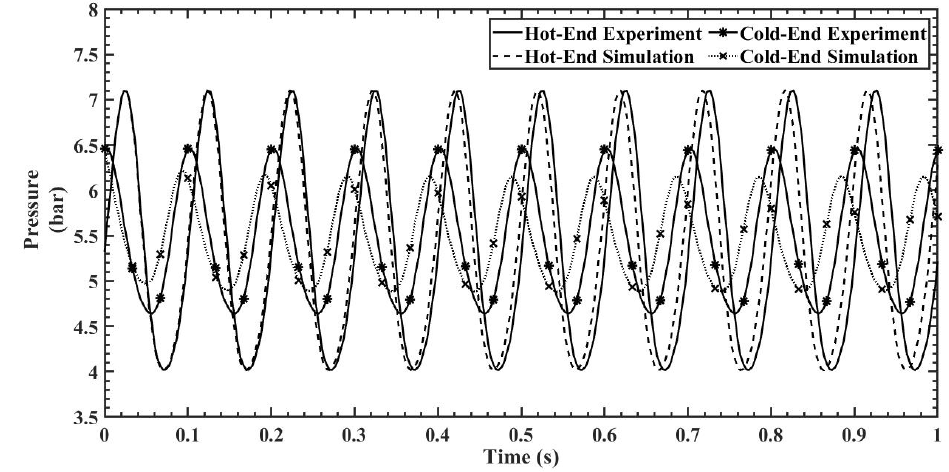
Figure 18. Hot- and cold-section pressure characteristics of a 200 mesh regenerator at 600 RPM. For a 200 mesh regenerator with a fluid frequency of 200 RPM, the deviation of the maximum pressure from the experimental result is found to be 5.3%, approximately